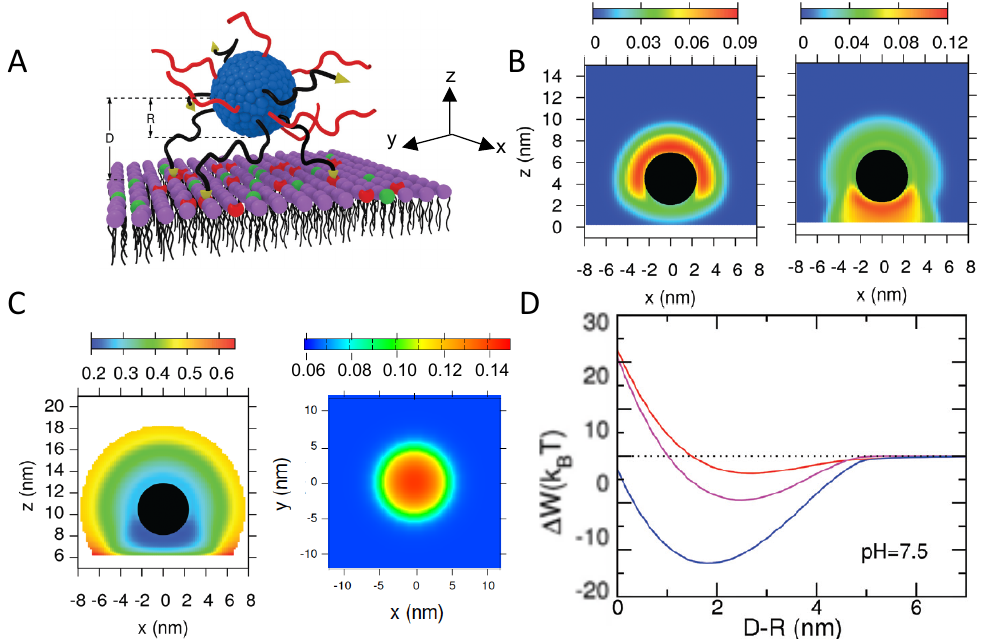
Figure 8. ( A ) Schematic illustration of a polymer-coated NP interacting with a lipid membrane. Neutral polymer chains are in red, while the polybases ( pK a = 7.5) with their ligand-end group are in black. Uncharged lipids are in purple, overexpressed receptors in red, and negatively charged lipids in green. ( B ) Contour maps of the polymer volume fractions for both neutral polymers (left panel) and polybase (right panel) for a NP of radius R = 2.5 nm close to the lipid layer for a pH = 7.5 and a salt concentration of 0.10 M. Surface density σ = 0.20 nm − 2 , N = 20 segments. ( C ) Coated NP interacting with a lipid membrane with both overexpressed receptors and charged lipids. Left panel: Contour map of the fraction of charged groups of the polybases on a NP close to the lipid membrane. The conditions are the same as in panel (b). Right panel: Contour map of the fraction of charged lipids in the membrane. The center of the NP is at (x; y) = (0; 0) and 2.0 nm above the membrane surface. The conditions are the same as in panel (b). ( D ) Free energy as a function of the distance between the NP surface and the lipid layer. The conditions are the same as in panel (b). The colors correspond to the three membranes modeled: no overexpressed receptors and negatively charged lipids (red), neutral lipid membrane with overexpressed receptors (magenta), and membranes with both overexpressed receptors and charged lipids (blue). (Reprinted with permission from the authors of [156]. Copyright 2013 The Royal Society of